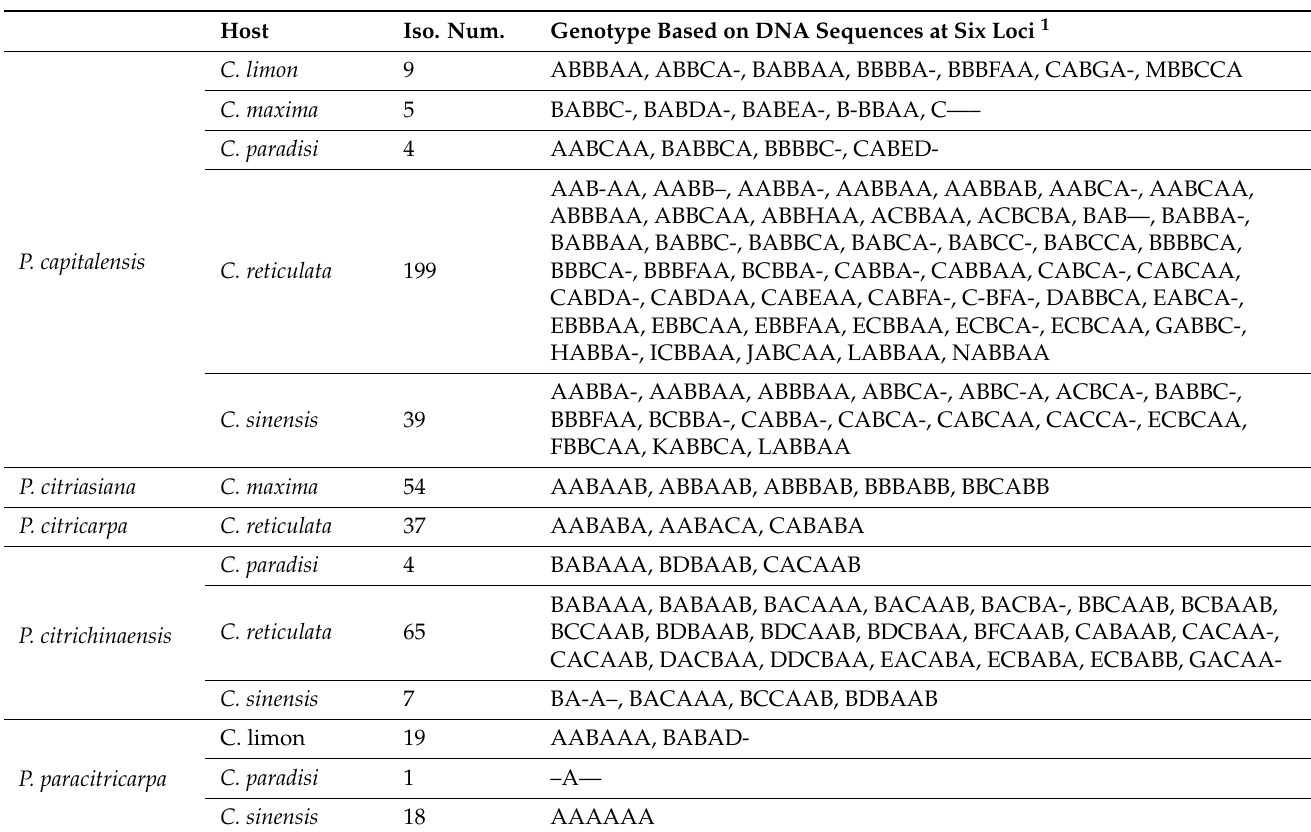
Table 2. Information of Phyllosticta isolates collected from citrus in China and their genotype statistics based on isolated host tree